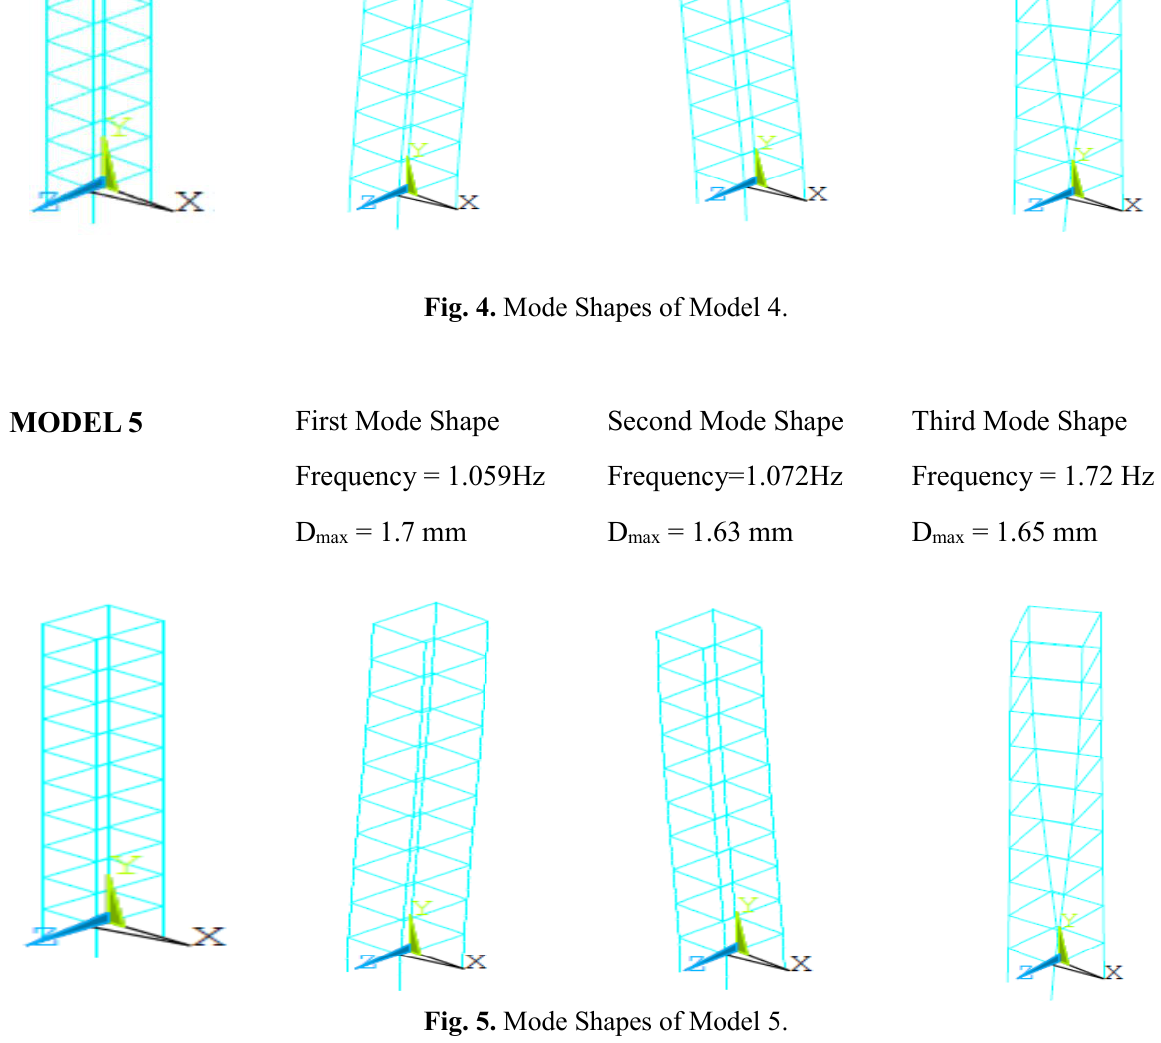
Fig. 5. Mode Shapes of Model